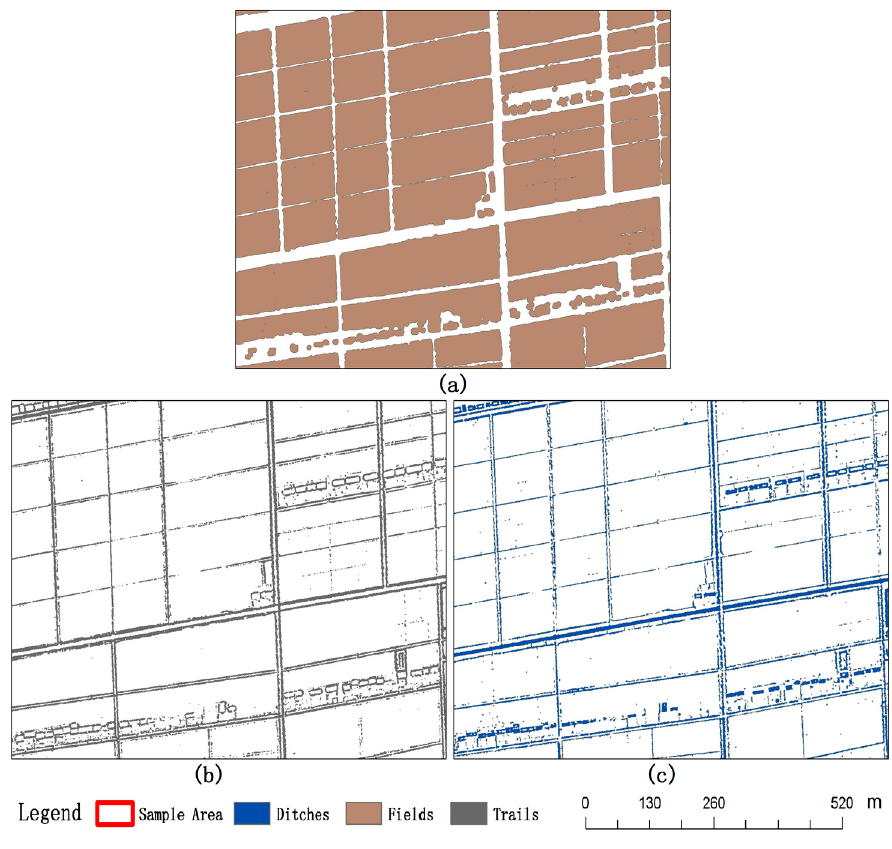
Figure 12. Detailed vector results of the sample area: ( a ) fields, ( b ) trails, and ( c ) ditches.